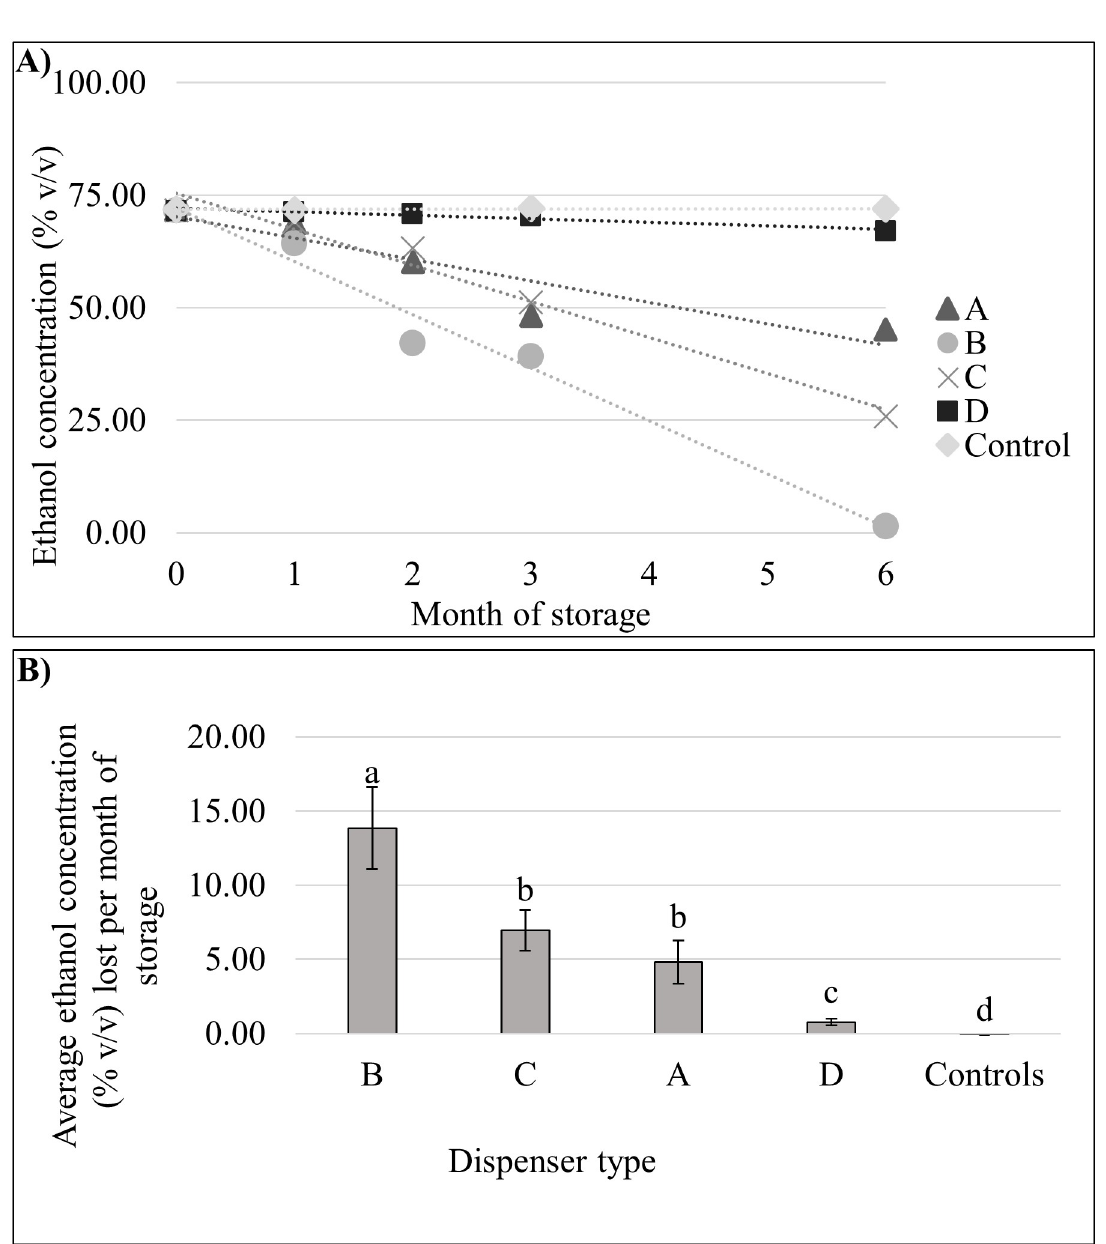
Fig 3. Observed ethanol loss in ABHS stored in bulk refillable dispensers (pooled across all ABHS types) under accelerated stability conditions (40 ± 2˚C, RH of 75 ± 5%). Rate of monthly ethanol loss of ABHS stored in various bulk refillable dispensers held in accelerated stability conditions. For both panels, ethanol content is pooled across all ABHS types (e.g., foam, gel, liquid/WHO), since ABHS type was not found to significantly impact the rate of ethanol evaporation (data shown in S1 Fig; P > 0.05). Controls were two sanitary sealed 1200mL refill bottles of ABHS products from GOJO Inc. (details in Materials and Methods). Panel A: Observed ethanol loss over 6 months of storage time for ABHS stored in bulk refillable dispensers. Samples were stored at 40 ± 2˚C, RH of 75 ± 5%, and aliquots for analysis were measured after 0, 1, 2, 3, and 6 months of storage. Bolded shapes on the graph represent mean ethanol percent (v/v) values for duplicate aliquots at each indicated time point. Dashed lines represent a linear fit trendline based on all data points. Dispenser types appear on the legend, and details of each dispenser type appear in S1 File in the supplemental materials. Panel B: Monthly loss of ethanol represented as the inverse slope of a linear trendline of ethanol content as a function of time when dispenser × ABHS combinations were stored for 6 months at accelerated conditions (from Panel A). Error bars represent standard error of the mean. Dispenser type was significantly associated with rate of ethanol loss ( P < .05) based on one-way ANOVA with dispenser type as treatment and average monthly ethanol loss as independent variable. Letters above each bar graph indicate statistically different mean ethanol percentages using Tukey’s HSD post-hoc test for separation of means.